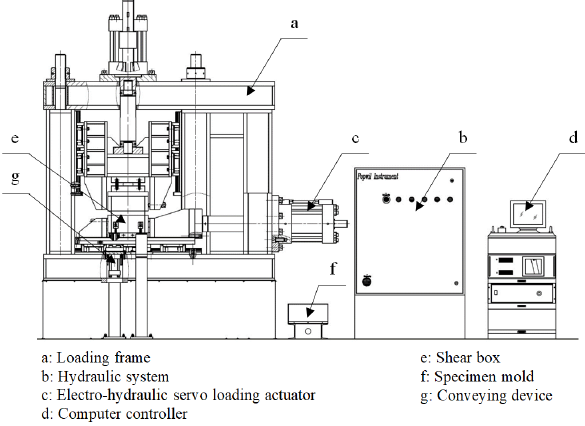
Figure 1: Self-developed multifunctional rock-soil contact damage test